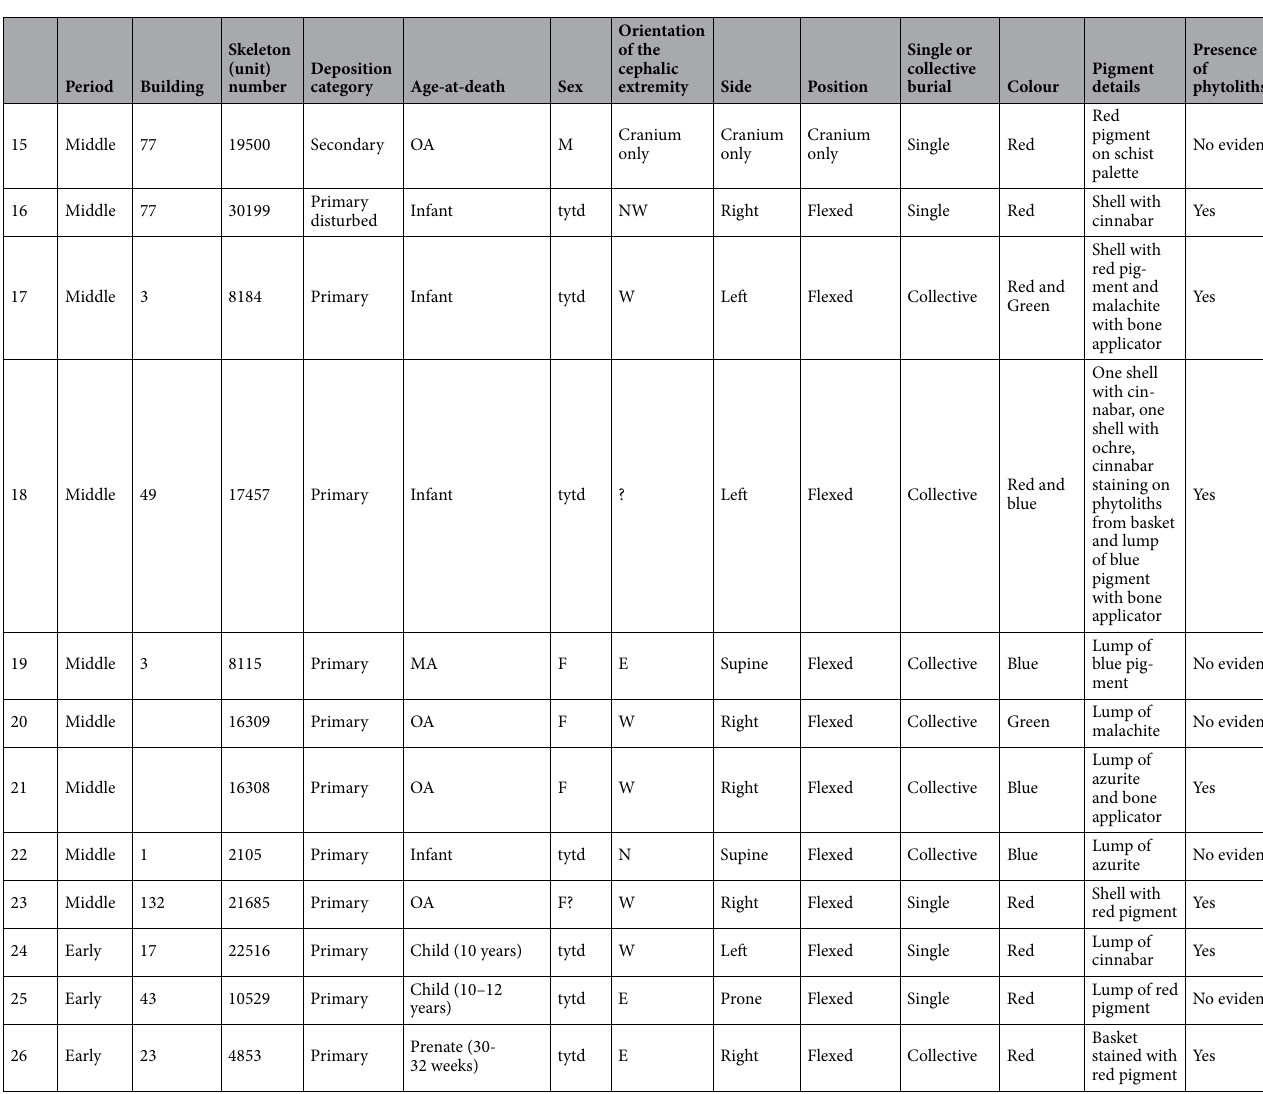
Table 1. List of Çatalhöyük primary and secondary human remains with pigments classified as (a) skeletons with direct pigment traces and (b) individuals with burial associations that contained pigment. OA old adults, colour. Table generated with Microsoft Office Excel 2016 (https:// www. micro soft. com/ en- us/ micro soft- 365/ excel).